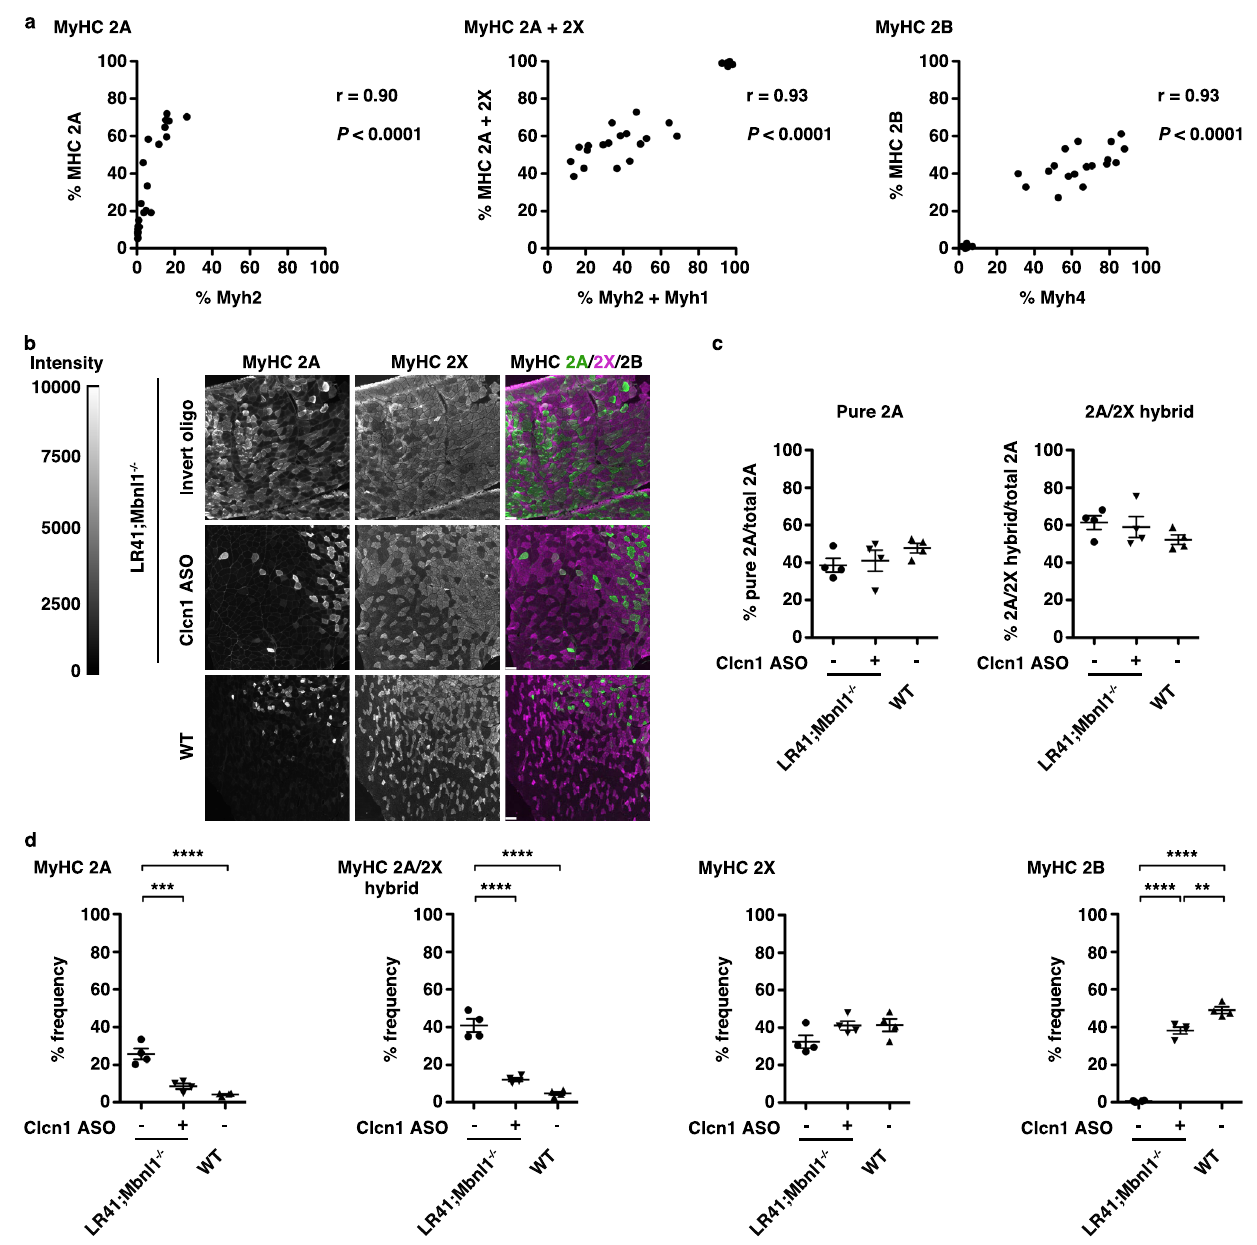
Fig.6|Quanti fi cationofMyHC2A/2Xhybrid fi bers.a Relationshipof Myh2 (left), Myh2 combined with Myh1 (middle), and Myh4 (right) transcript expression by ddPCR ( x -axes) with quanti fi cation of the corresponding proteins MyHC 2A (left), MyHC 2A combined with MyHC 2X (middle), and MyHC 2B (right) by immuno- fl uorescence(IF)( y -axes)inLR41; Mbnl1 − / − ( N =7),LR20b( N =4),andWT( N =3).The Pearson correlation coef fi cient r and P -value for each are shown. b We used anti- bodies targeting MyHC 2A and 2X and immuno fl uorescence (IF) analysisof MyHC proteinexpressioninTAmusclesofLR41; Mbnl1 − / − treatedwitheithertheClcn1ASO or the invert oligo ( N =each group). Untreated wild-type (WT) TA muscles ( N =4) served as controls. Representative images of each are shown. Fluorescence